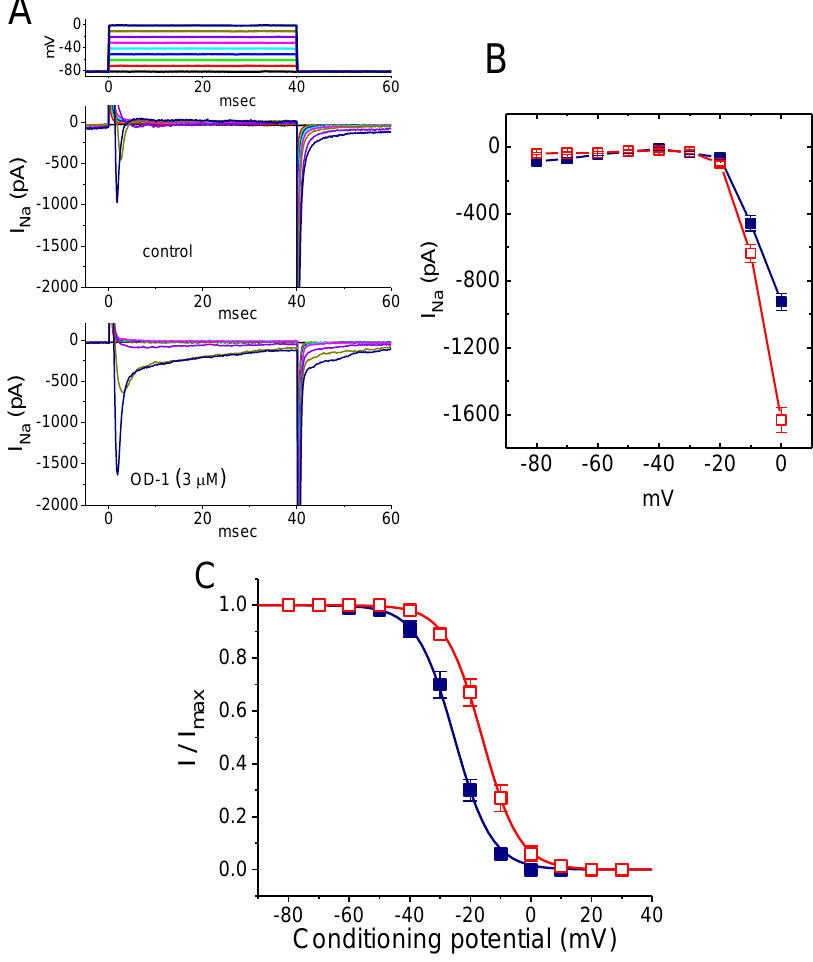
Figure 2. Average conductance–voltage relationship ( A , B ) and steady-state inactivation curves ( C ) of peak I Na obtained with or without the addition of OD-1. The experiments were conducted in cells bathed with Ca 2+ -free Tyrode’s solution, and the recording pipette was filled with a Cs + -containing solution. ( A ) Representative I Na traces evoked by different voltage steps are shown in the uppermost part. The upper part indicates current traces obtained in the control, while the lower part is those taken during exposure to 3 μM OD-1. ( B ) Average conductance–voltage relationship of peak I Na in the absence ( ■ ) and presence (□) of 3 μM OD-1 (mean ± SEM; n = 9–11 for each point). Notably, the presence of OD-1 increased the peak conductance of I Na with no change in the overall conductance-versus-voltage relationship to the current. ( C ) Steady-state inactivation curve of I Na obtained with and without the addition of 3 μM OD-1 (mean ± SEM; n = 9 for each point; absence ( ■ ) and presence (□) of 3 μM OD-1). Data were analyzed using a one-way ANOVA with the least-significant difference post hoc comparisons.